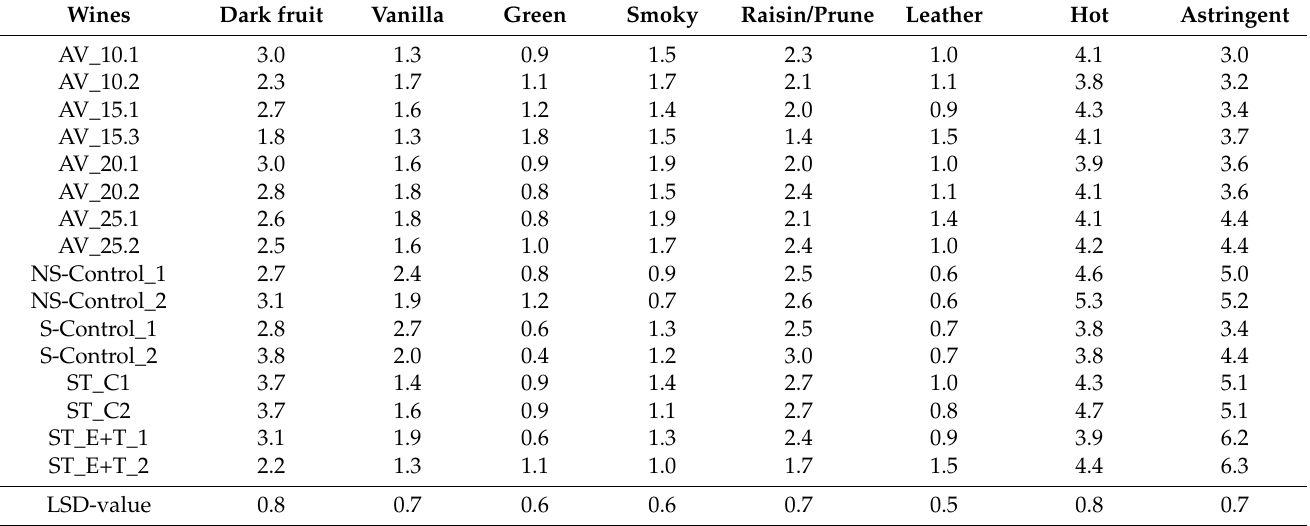
Table 5. Overall means and Fisher’s least significant difference (LSD) values for significant panel 2 descriptive analysis attributes (n =